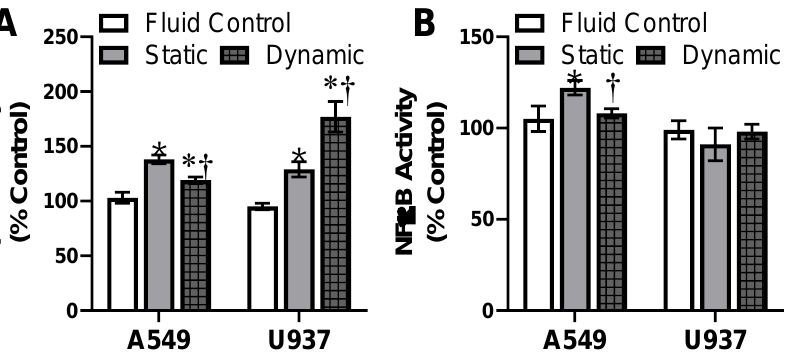
Figure 5. Activation of oxidative stress protein markers. Following exposure to 5 µg/mL AgNP, under both static and dynamic conditions, the A549 and U937 cells underwent evaluation for ( A ) p53 and ( B ) NFκB activation. Activation was determined by quantifying the phosphorylated state of target intracellular proteins, normalized by the total amounts of that protein. Activation of chosen oxidative stress pathways varied with cell type and exposure environment. Dynamic flow without AgNP conditions was also included as fluid control. * and † indicate statistical significance compared to the untreated control and between static and dynamic conditions, respectively. n = 3, p < 0.05.